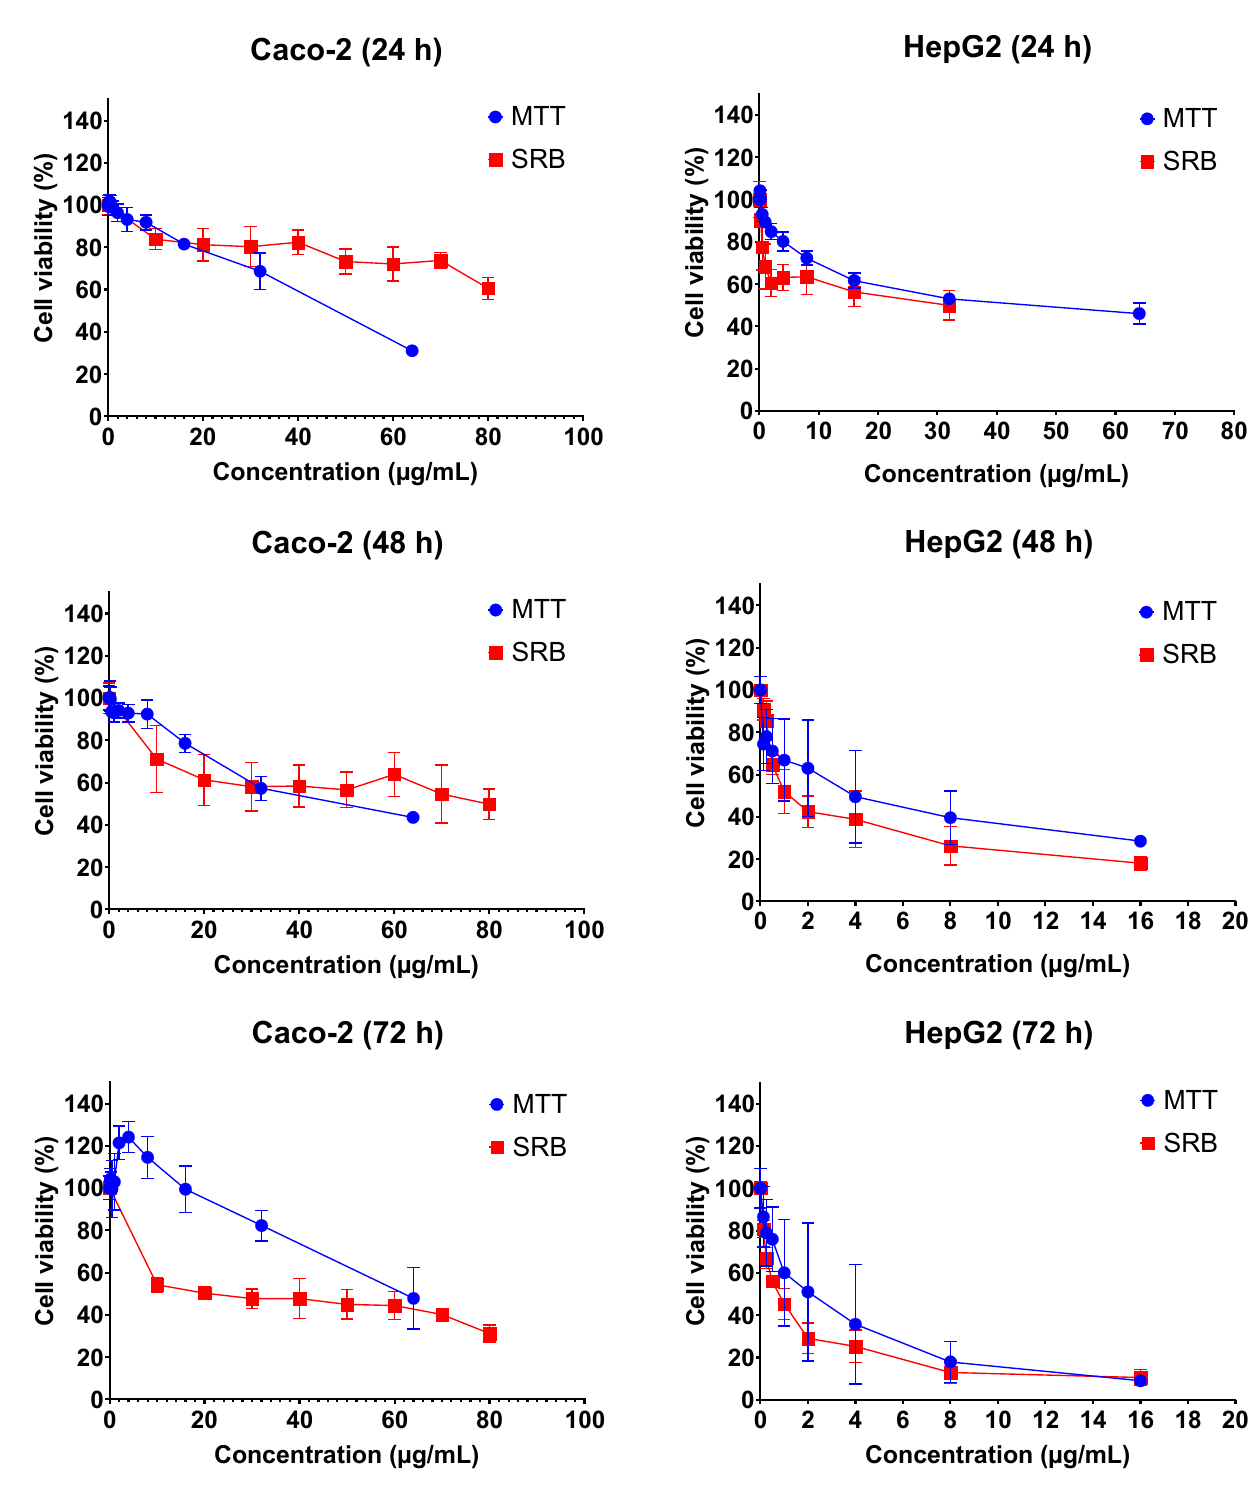
Figure 2. Concentration – response curves for the individual 24 h, 48 h and 72 h treatments with AFB1 in Caco-2 and HepG2 cells. Data (three technical replicates and three independent repetitions) are expressed as mean ± SD.